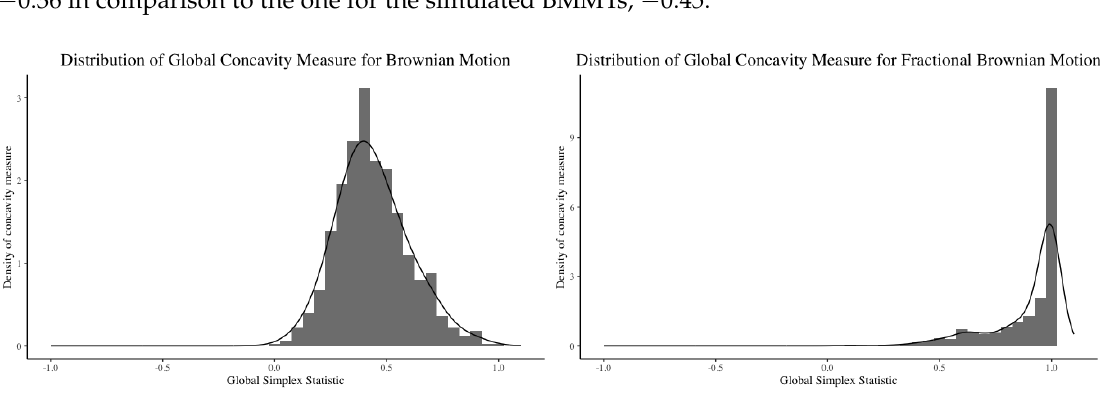
Figure 3. Distribution of global simplex statistics for Brownian motion ( left ) and fractional Brownian motion ( right ).